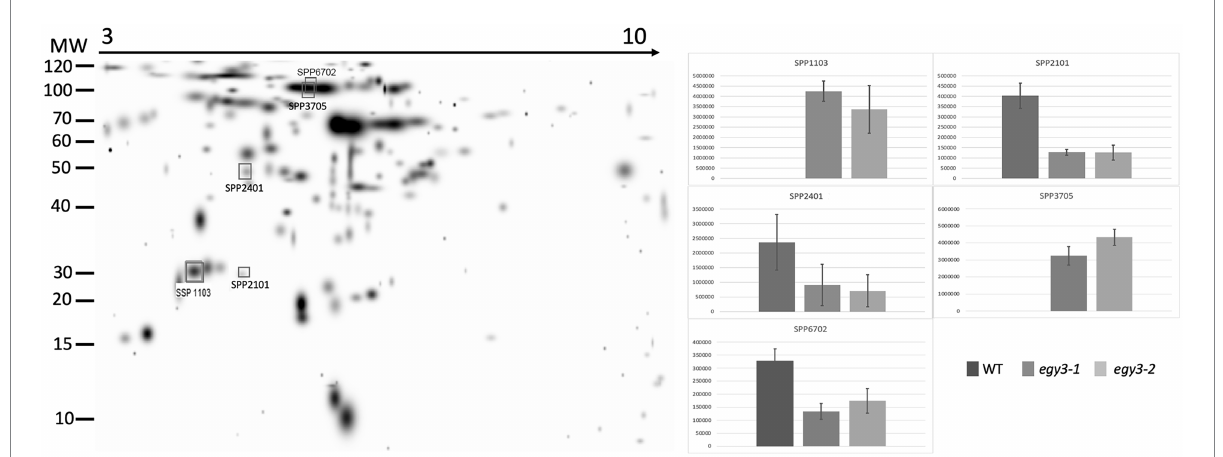
FIGURE 6 Two-dimensional electrophoresis gels of stroma proteins isolated from wild-type (WT) and egy3-1 and egy3-2 lines, exposed to 3 h of 400 ° C. Proteins were separated using 2-D gel electrophoresis with IEF (pH 3–10) and detected with Coomassie Brilliant Blue staining. The image is digitally generated using the PDQuest Advanced 2-D Gel Analysis Software, (Bio-Rad, Hercules, United States) master gel, based on four electrophoretic separations made for two independent biological repetitions. The protein accumulation in the bar graphs was expressed in arbitrary